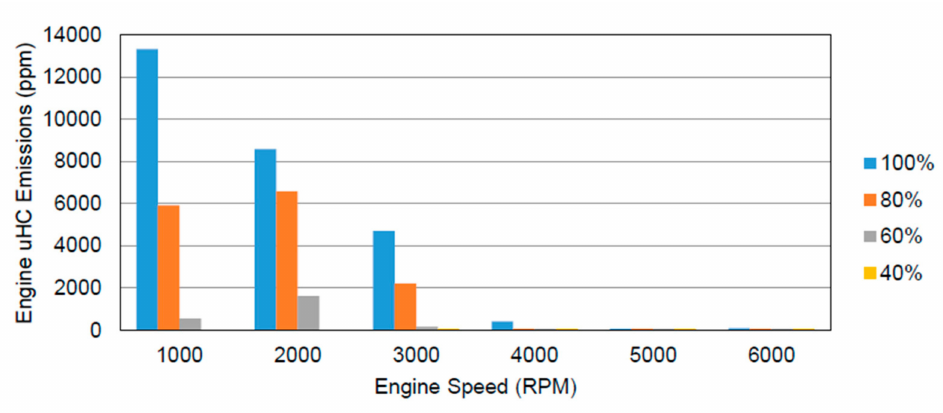
Figure 22. Baseline engine uHC (Unburned Hydrocarbons) emissions at di ff erent engine